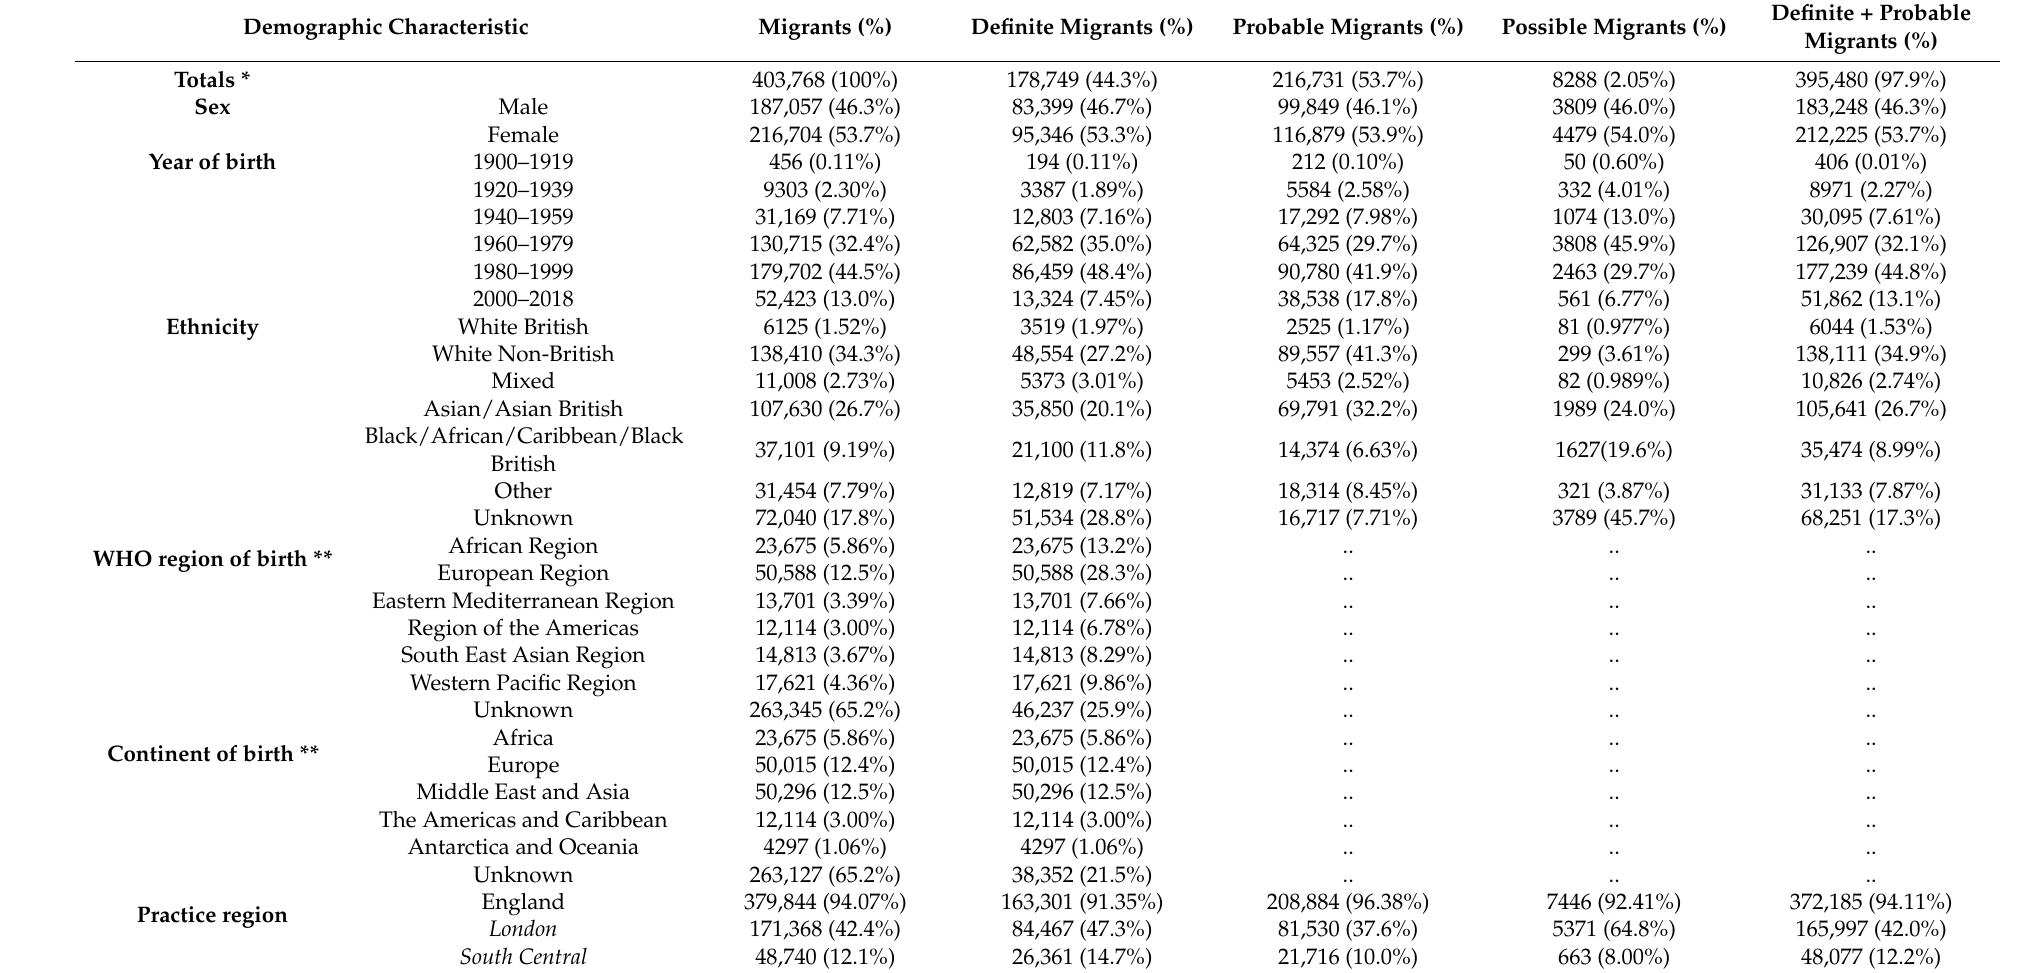
Table 1. Demographic characteristics of recorded migrants in CPRD GOLD by certainty of migration status